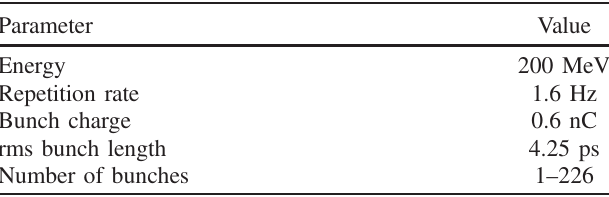
TABLE IV. Nominal beam parameters of CALIFES [14].